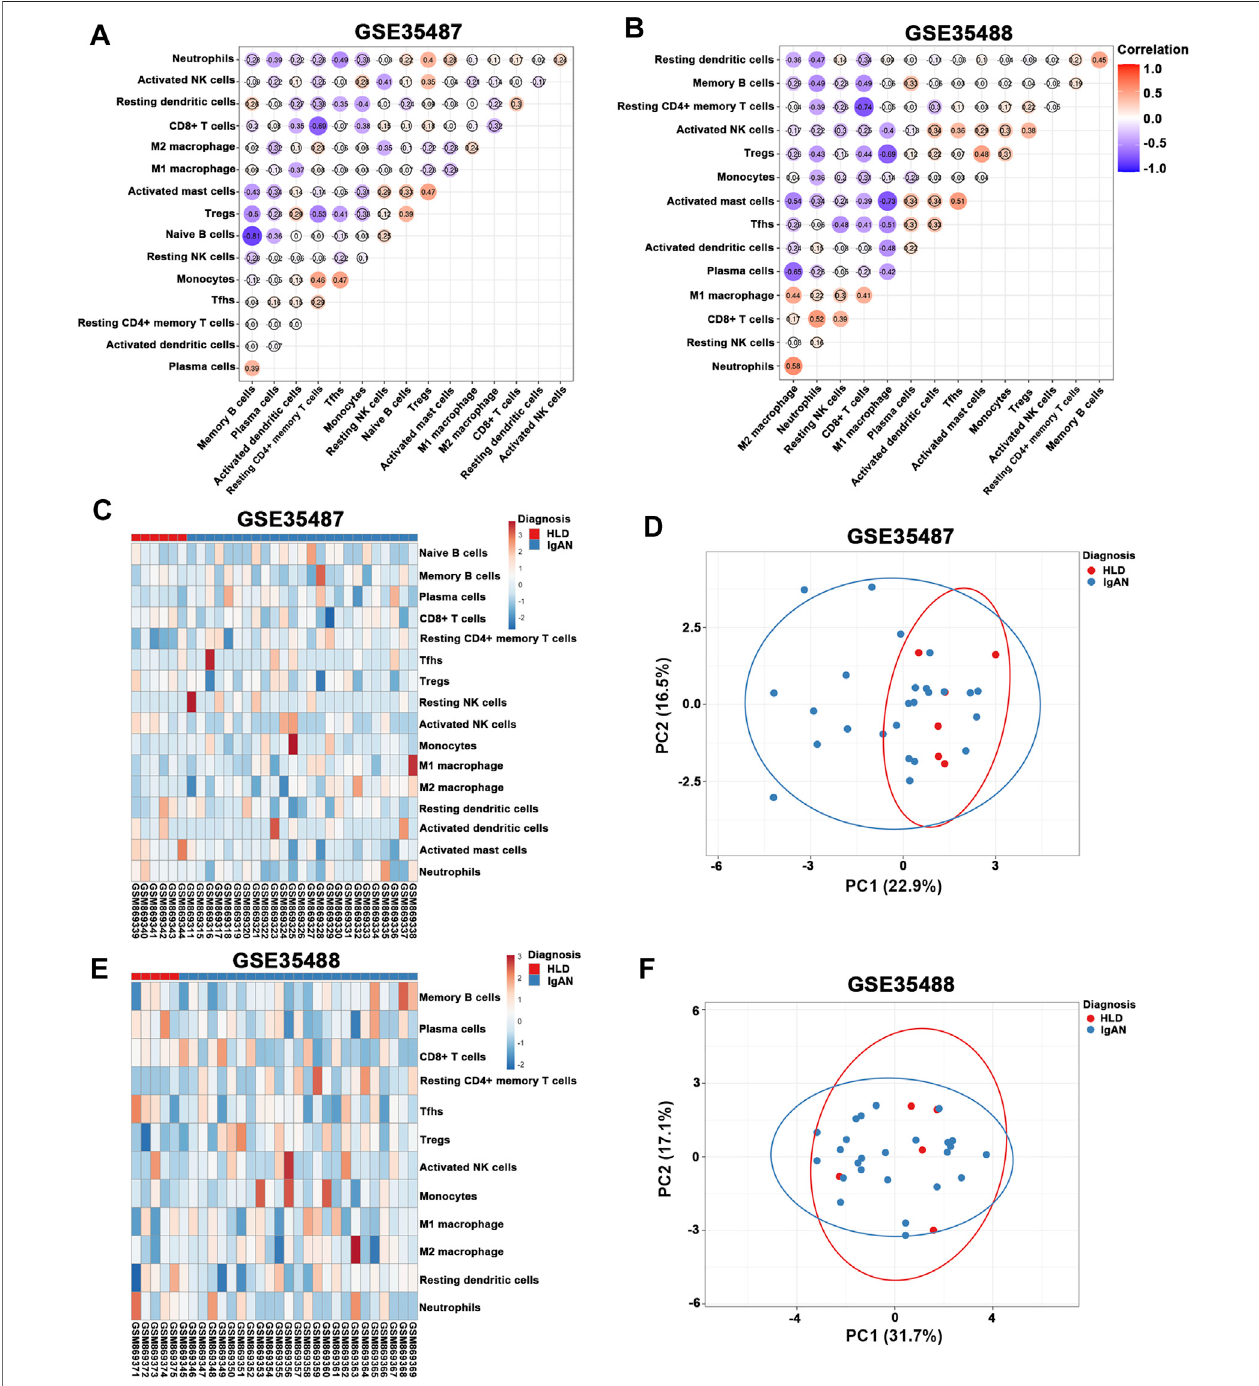
FIGURE 7 | (A,B) Correlation heat map of 22 types of immune cells in GSE35487 and GSE35488. Dot size shows the extent of their relationships and dot color indicates if they are positively related (red dots) or negatively related (blue dots). The number inside dots indicates the corresponding correlation value between two immune cells. The darker the color, the stronger the correlation. Colored dot without a black line around it denotes signi fi cance ( p < 0.05). (C,D) Heat map and principal component analysis (PCA) cluster plot of immune cells in GSE35487. (E,F) Heat map and PCA cluster plot of immune cells in GSE35488.